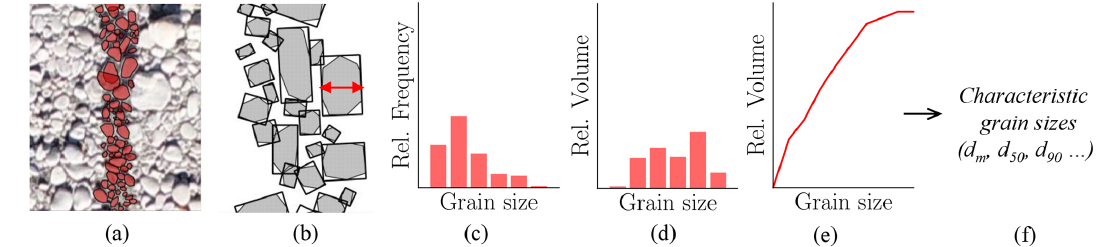
Figure 4. Overview of the line sampling procedure. (a) Digital line sample with 100–150 grains, (b) automatic extraction of the b axis, (c) relative frequency distribution of grain sizes, (d) relative volume distribution, (e) grading curve, and (f) characteristic grain sizes (e.g., d m ).